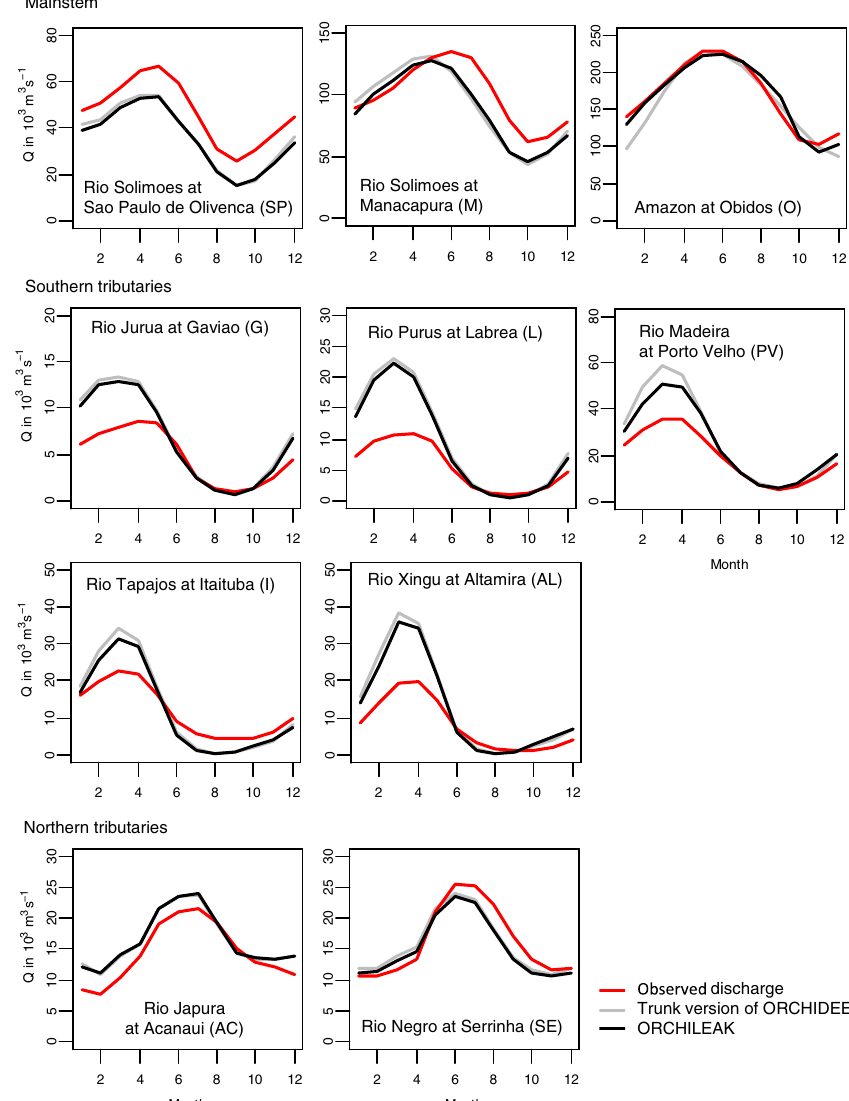
Figure 10. Simulated versus observed monthly discharge in the Amazon River and its major tributaries. The simulated discharge represents the average over the simulation period 1980–2000. For the stations at Rio Negro, Rio Purus and Rio Tabajos as well as for the Amazon at Obidos, observed discharges are derived from ORE HYBAM gauging data for the same period. For the other stations, long-term average monthly discharges from GRDC data set have been used, which cover a longer period: Amazon at Sao Paolo de Olivenca